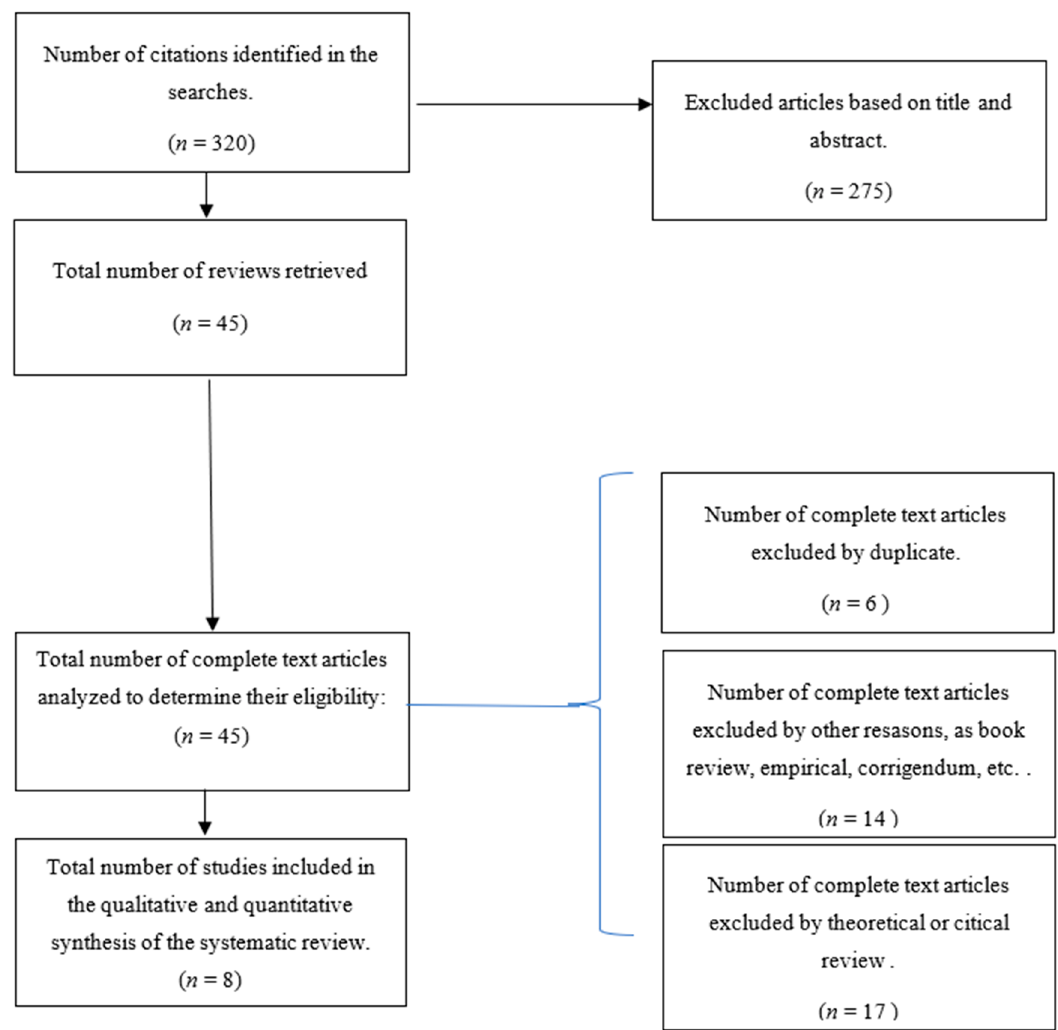
Figure 1. Flow diagram of the information through the different phases.